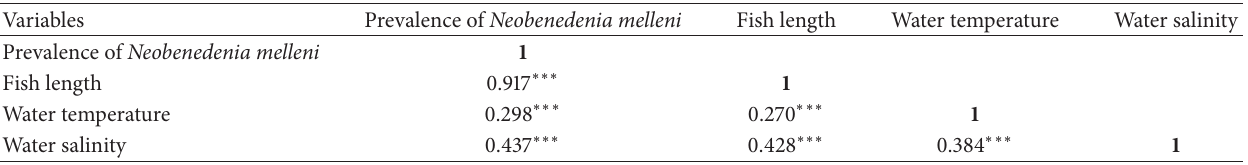
Table 2: Correlations between variables using bivariate analysis.